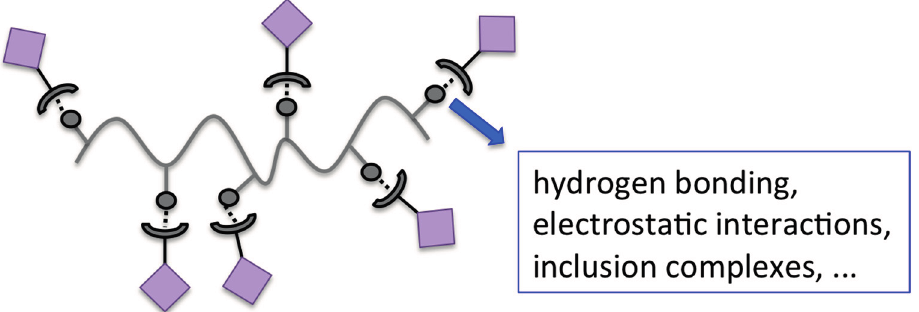
Figure 2. Schematic illustration of non-covalent dye binding to